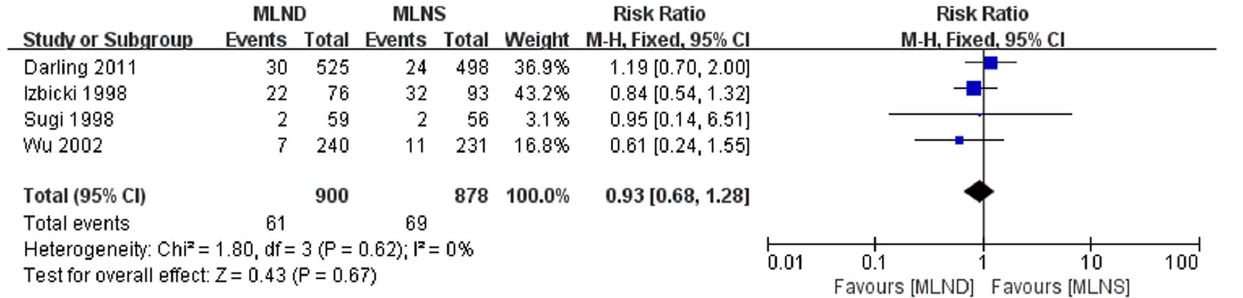
Figure 4. Forest plot of local recurrence for the MLND vs. MLNS groups. MLND, mediastinal lymph node dissection; MLNS, mediastinal lymph node sampling; RR, risk ratio; CI, confidence interval.